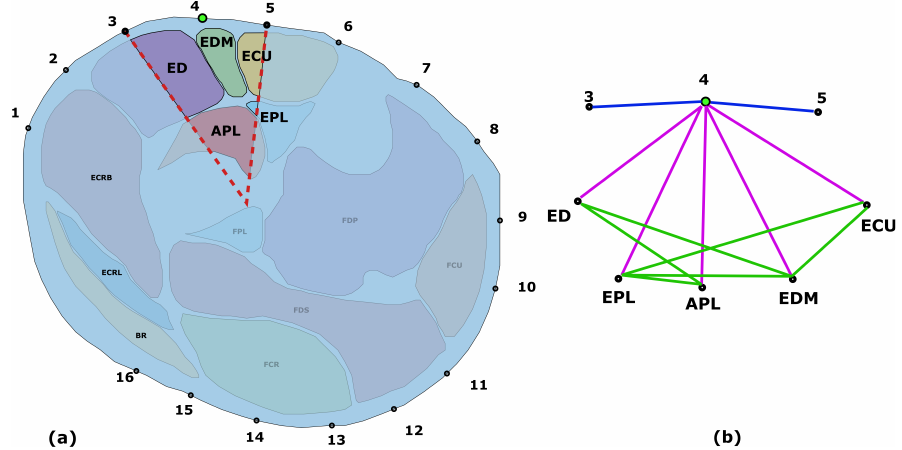
Figure 5. Example of one step of the graph creation. (a) Sector belonging to one of the electrodes, indicated with a green dot. The muscles that are included (ED, EDM, ECU, APL, and EPL) are highlighted with the area that is accounted for. (b) Graph created from the section considered in (a). e-e edges are indicated in blue, e-m edges are indicated in purple and m-m edges are indicated with green